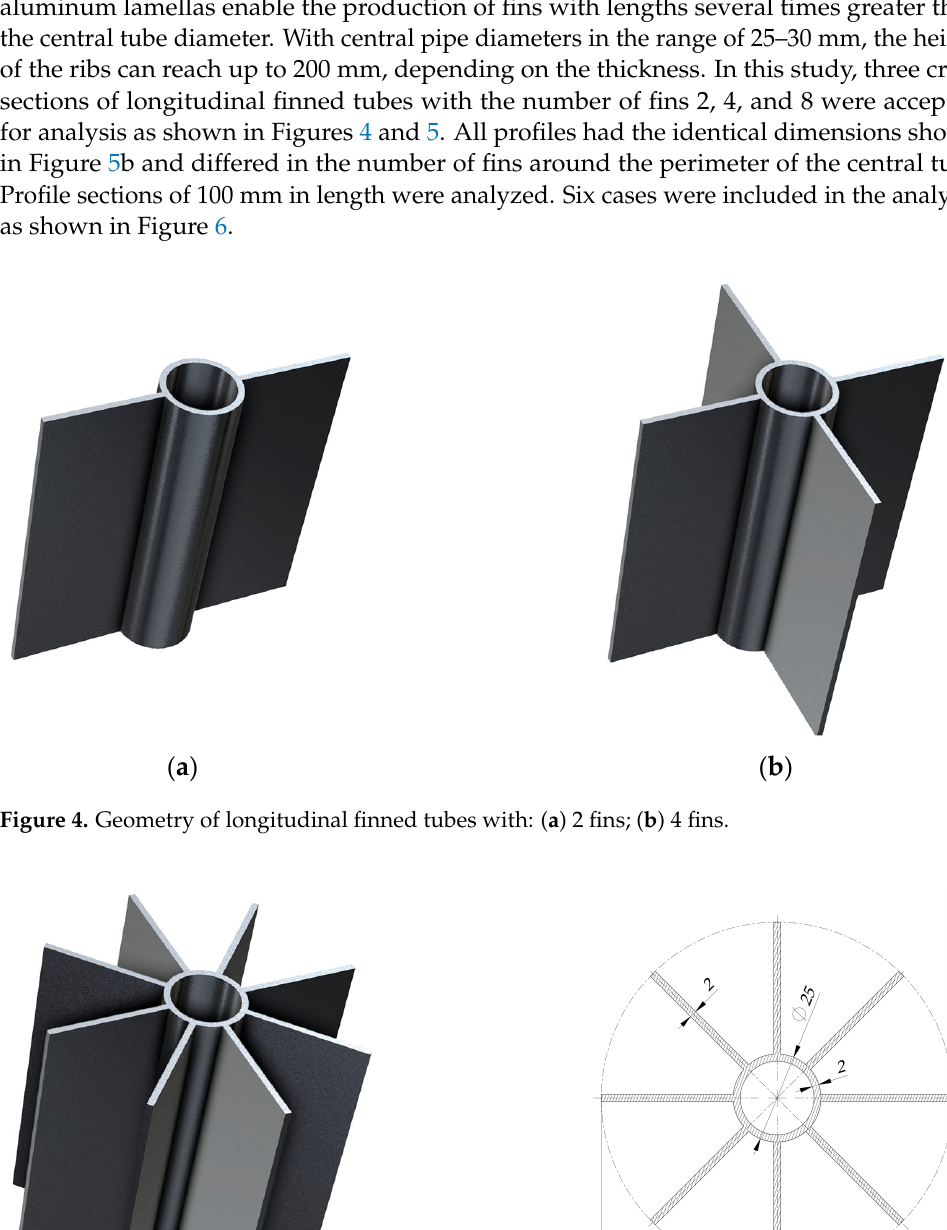
Appl. Sci. 2022 , 12 , 10865